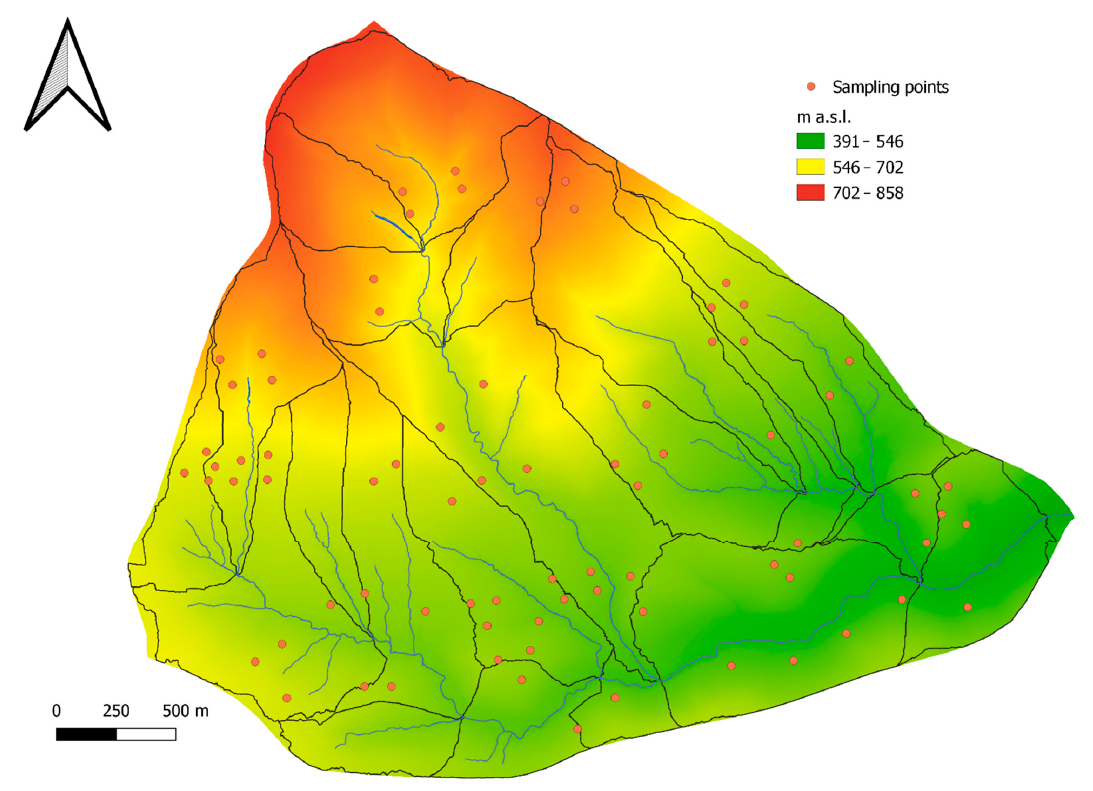
Figure 1. Location of sampling in Smugawka catchment.